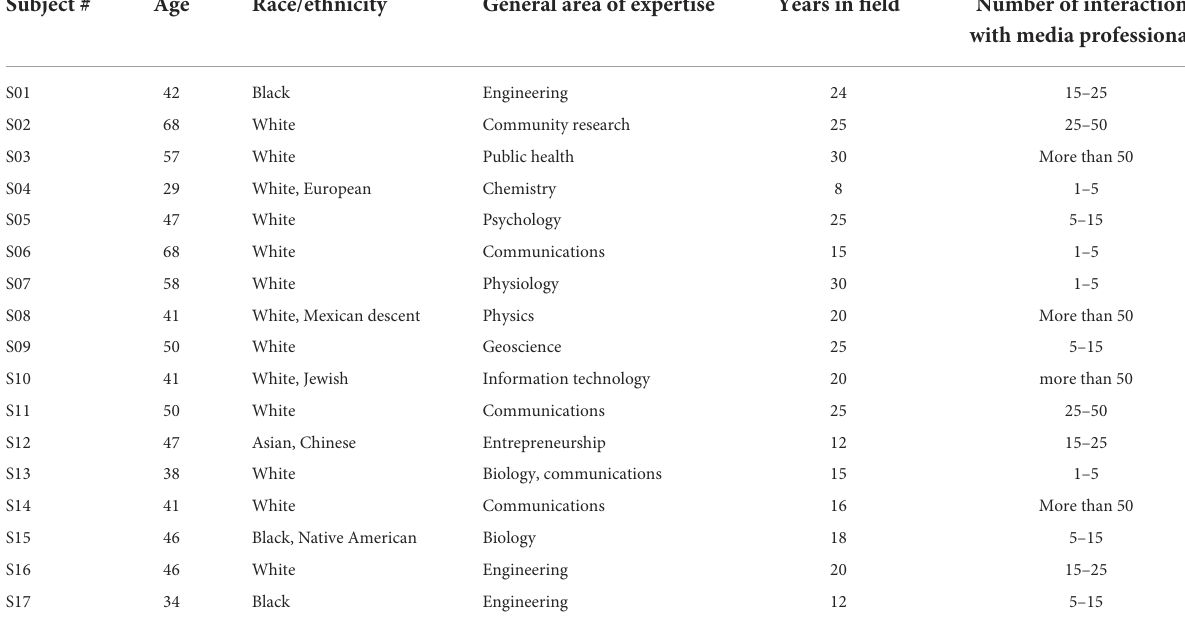
TABLE 1 Study 1 interviewee